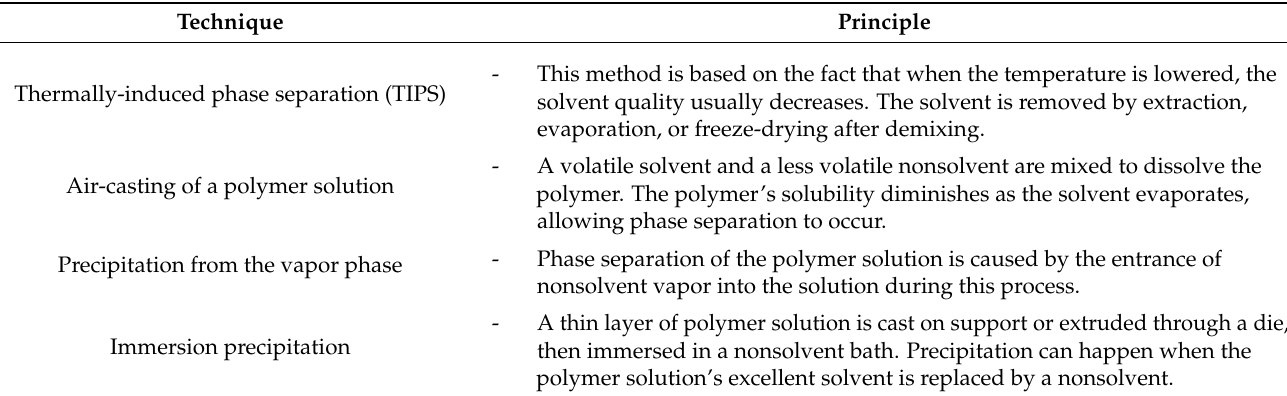
Table 2. Membrane synthesis by using phase separation